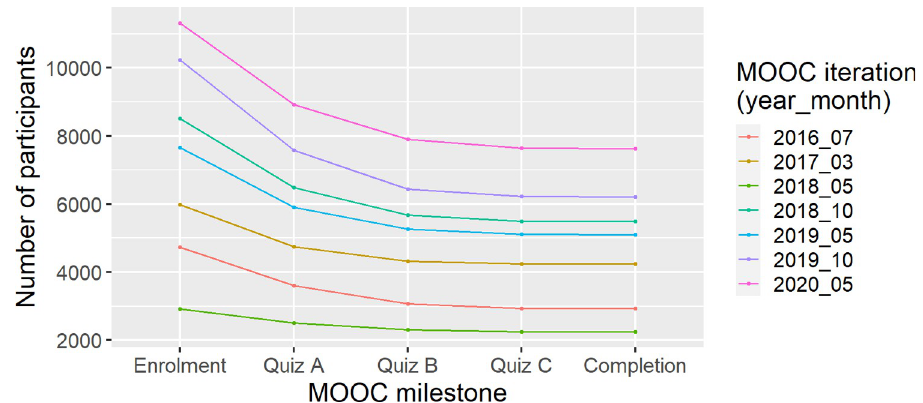
Fig 3. Numbers of participants participating at each stage of the Preventing Dementia MOOC for each of the seven iterations of the course (2016_07, 2017_03, 2018_05, 2018_10, 2019_05, 2019_10, 2020_05). The largest attrition occurred during the first module for all iterations.